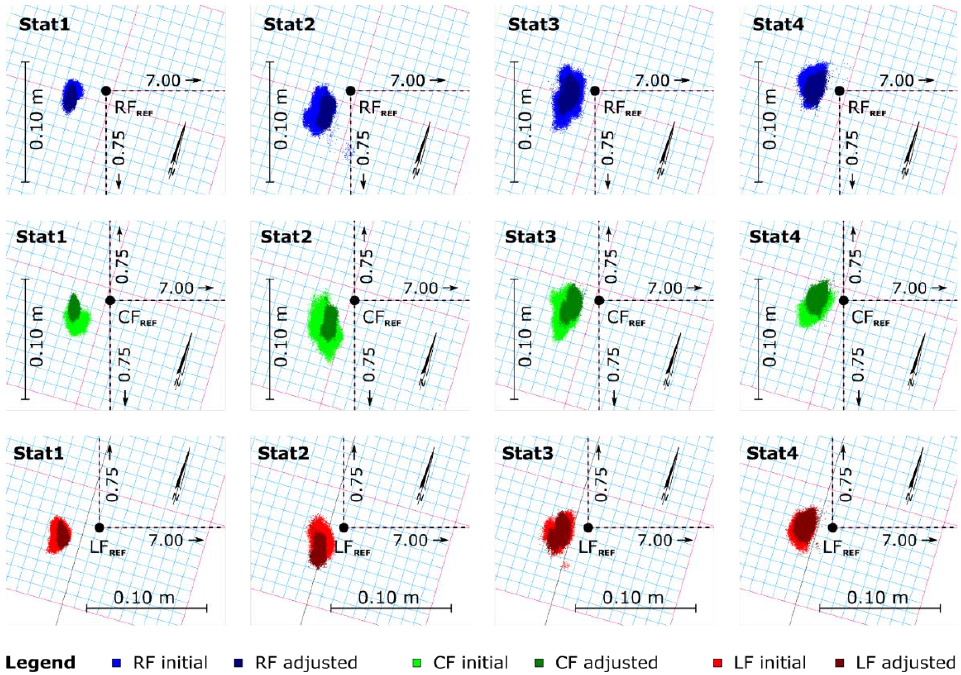
Figure 8. Results of the CLS adjustment of the front-line LF, CF, and RF receivers’ observations. The most precise initial (post-processed) coordinates were obtained in static session Stat1. The least precise results occurred in session Stat3, especially in the case of the LB receiver (top panel of Figure 9). The CLS estimat ion resulted in a decrease in the subsets’ standard deviation values. Part of the estimates of the coordinates of the frame back-line receivers was significantly affected by the anomalous LB receiver coordinates.